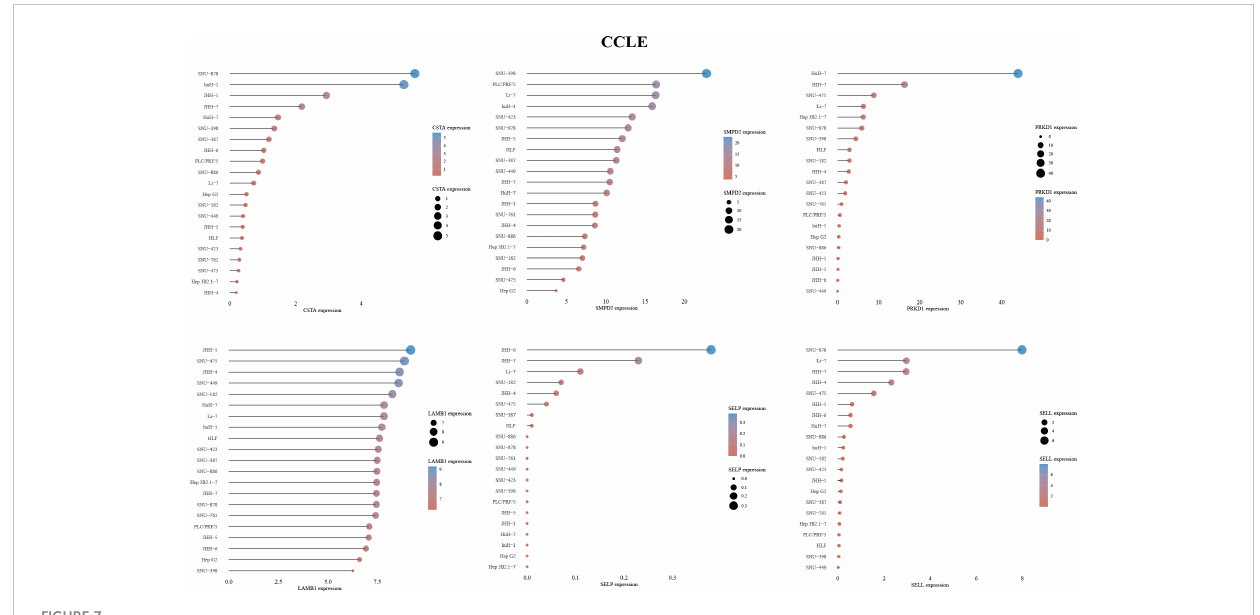
FIGURE 7 6-SPGs expression patterns in HCC cell lines based on CCLE